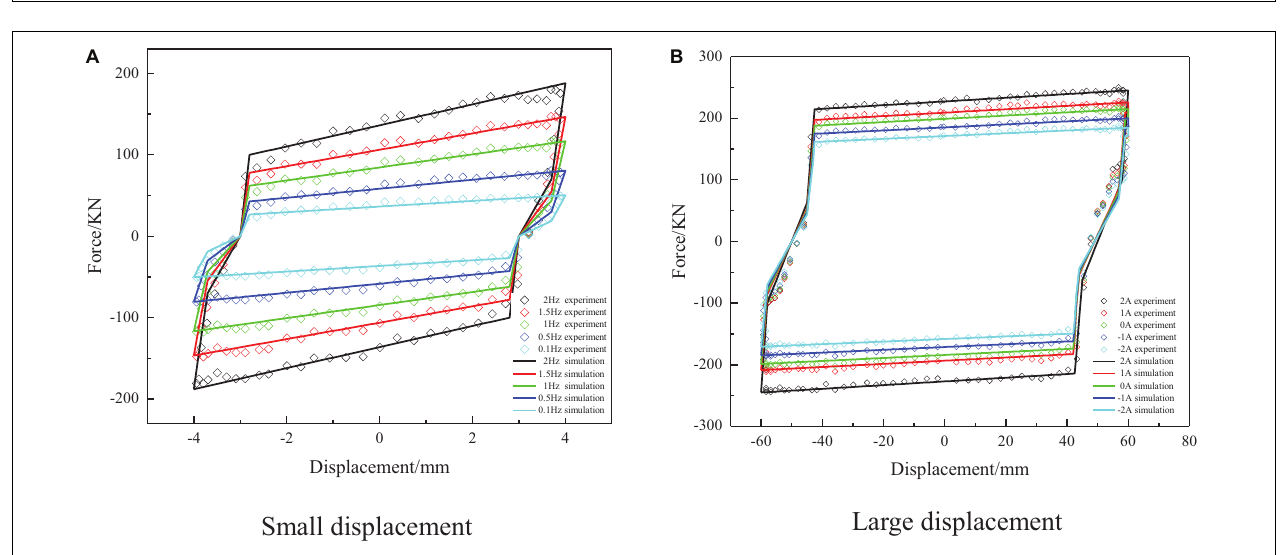
FIGURE 7 | Model and experimental results for force-displacement relationship curves: (A) small displacement and (B) large displacement.